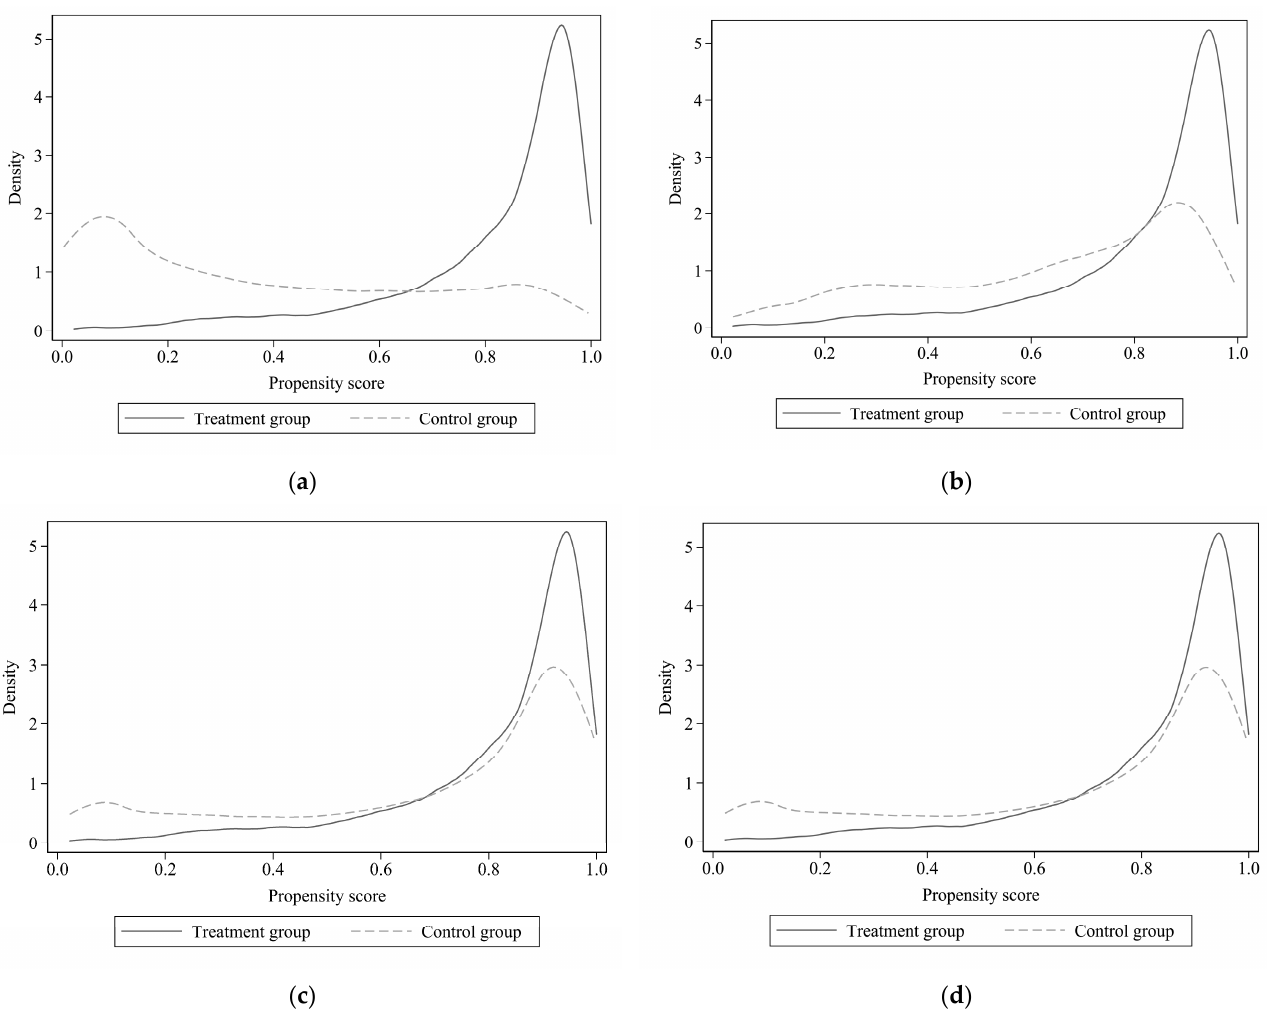
Figure 1. Probability distributions of propensity score between treatment and control groups before and after matching for Model (1). ( a ) Before matching, ( b ) nearest neighbor (1 to 4), ( c ) radius (caliper), ( d ) kernel. Table 4. Results of PSM estimation.